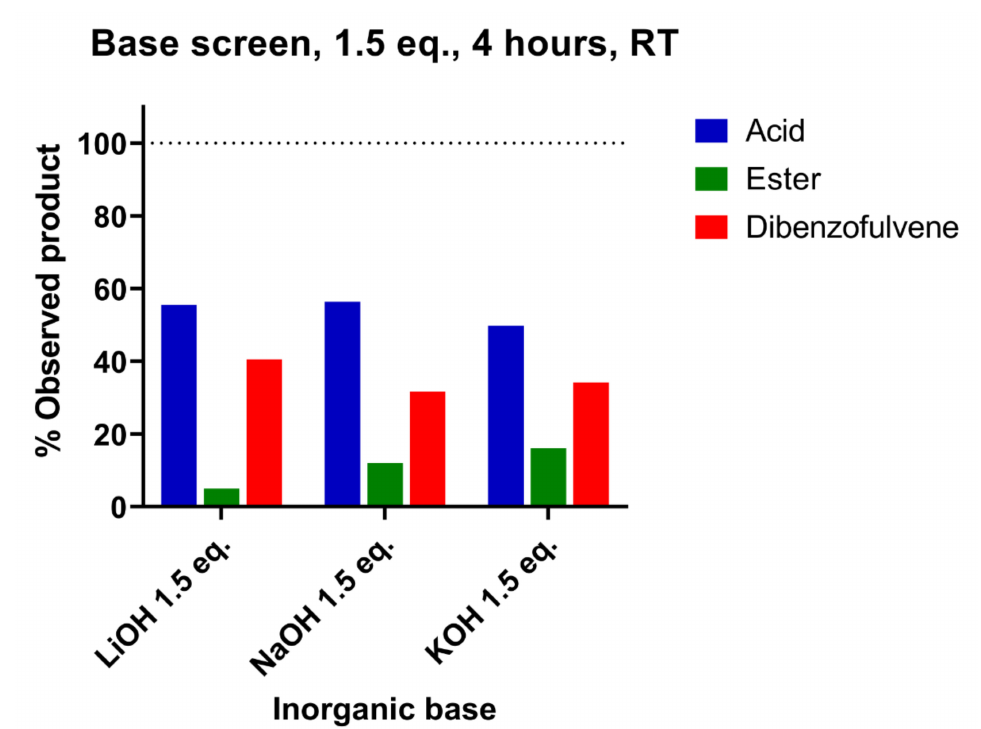
Figure 2. Screening of the inorganic hydroxide in an acetone/water ratio of 2.3:1 at RT for 4 h using: 1.5 eq. of LiOH; 1.5 eq. of NaOH and 1.5 eq. of